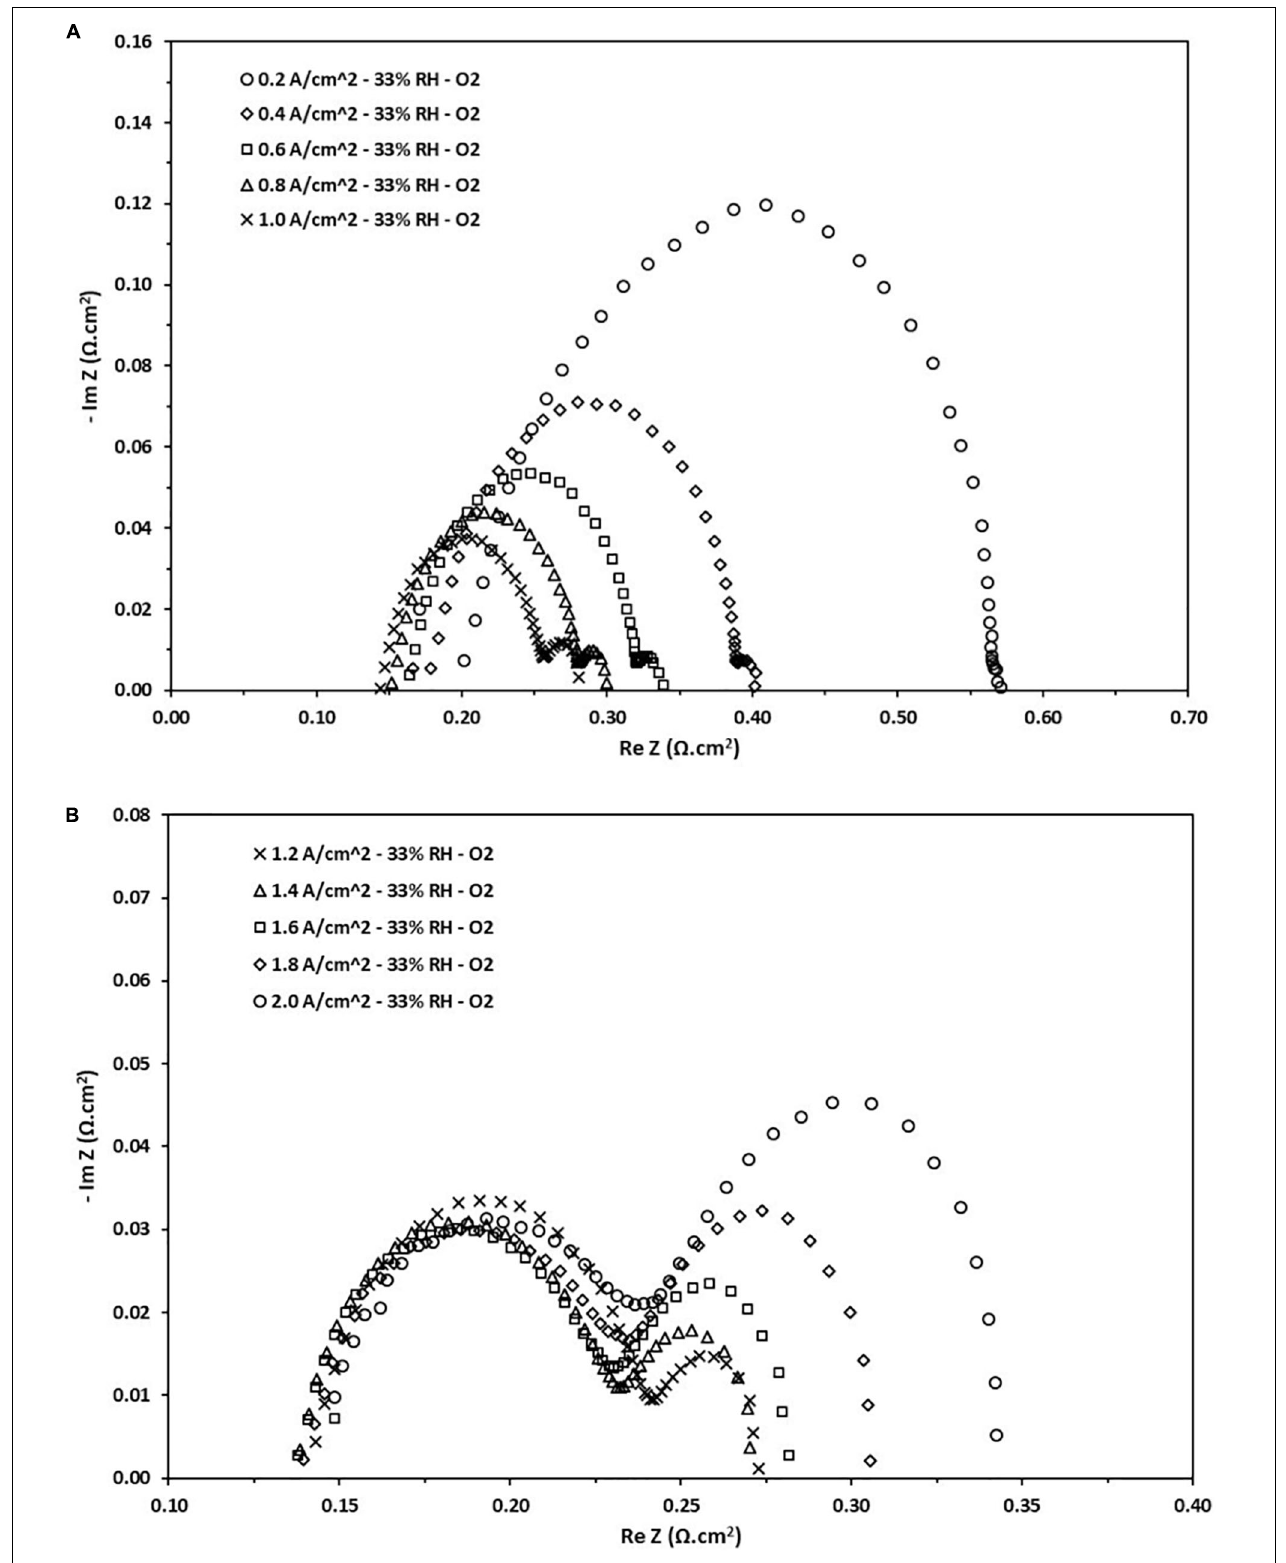
FIGURE 6 | Nyquist diagram obtained from the EIS test at different current loads at 33% RH. (A) Density current from 0.2 to 1.0 A/cm 2 . (B) Density current from 1.2 to 2.0 A/cm 2 .